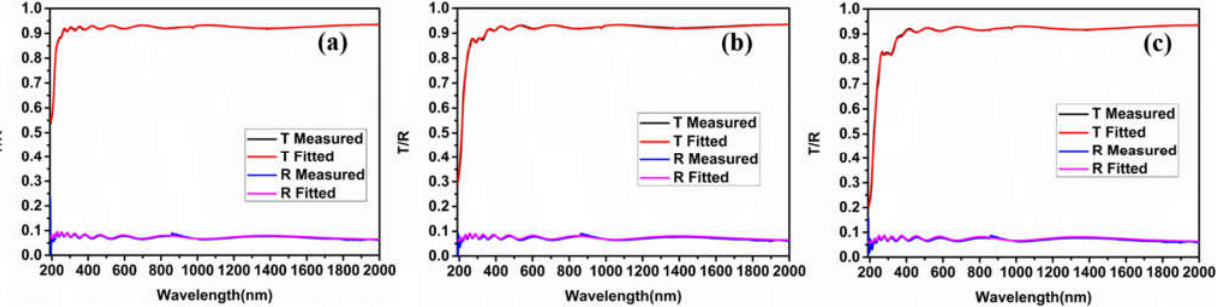
Figure 4. Fitting and measuring results of optical s pectra from 190 nm to 2000 nm of YbF 3 films prepared at different ion energies. ( a ) 0 eV. ( b ) 180 eV. ( c ) 360 eV. prepared at different ion energies. ( a ) 0 eV. ( b ) 180 eV. ( c ) 360